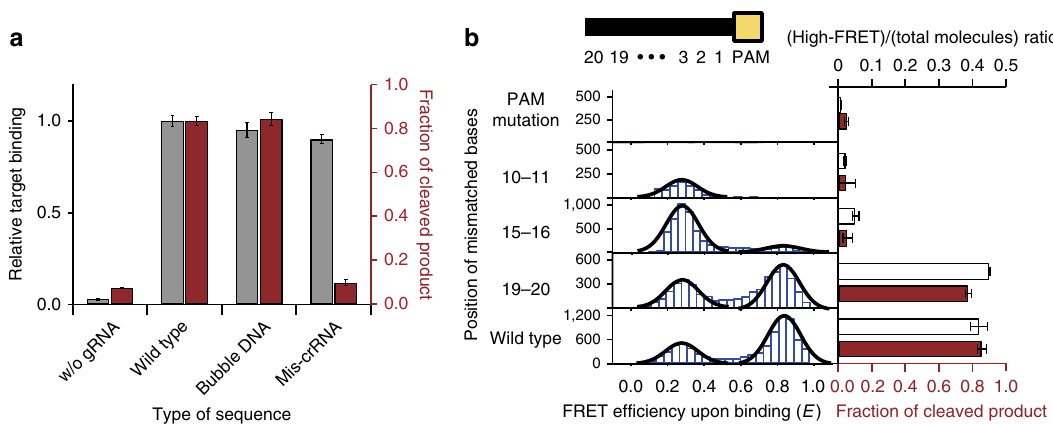
Figure 4 | Cas9 cleavage activity with various mutated target DNA. ( a ) The relative target binding (grey bars) versus the fraction of cleaved product (red bars) for DNA sequences containing various positions of mismatched bases. (mean ± s.e.m., n Z 5). ( b ) Histograms of FRET upon binding with each mismatched mutant with Gaussian fits (black line). The ratio of high-FRETstates to all DNA-bound states calculated from the FRET histograms (white bars) versus the DNA cleavage efficiency (red bars) for different DNA sequences containing various positions of mismatched bases. The base positions are labelled by numbering from the 5 0 end of PAM as shown on top panel.